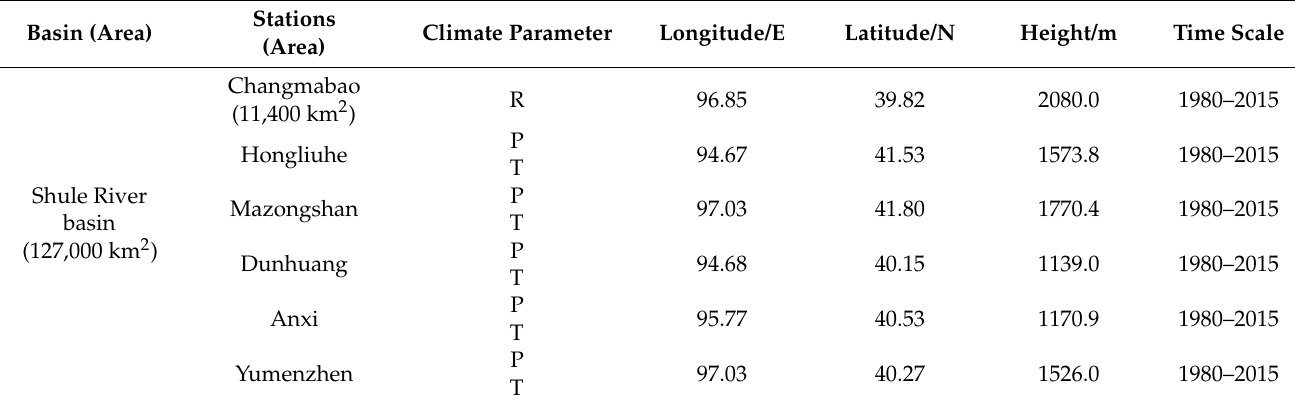
a R stands for runoff. b P stands for precipitation. c T stands for temperature. The runoff in the table is calculated by the continuous measured discharge hydrograph method and temporary curve method, and the standard deviation of the main curve is 3.0%.